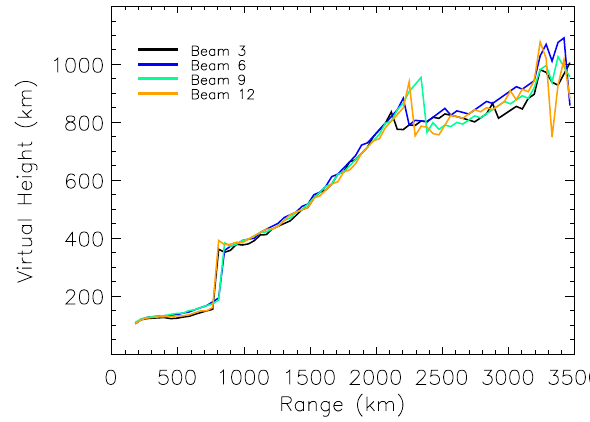
Fig. 12. The virtual height models determined from the Saska- toon data set. The yellow lines represent the peak virtual height variations determined for four different beams as shown in Fig. 11. The green curve shows the 1 -hop E-region model determined by 2 fitting a quadratic to the data below 790km range (as highlighted by the vertical dashed line). The black curve shows the 1 -hop F- 2 region model determined by fitting a quadratic to the data between 790 and 2130km range (as highlighted by the two vertical dashed lines). The red curve shows the 1 1 -hop F-region model determined 2 by fitting a quadratic to the data above 2130 km range. The two ver- -hop and 1 1 -hop F-region overlap tical dotted lines delineate the 1 2 2 region where backscatter for both propagation modes occurs with a significant probability.